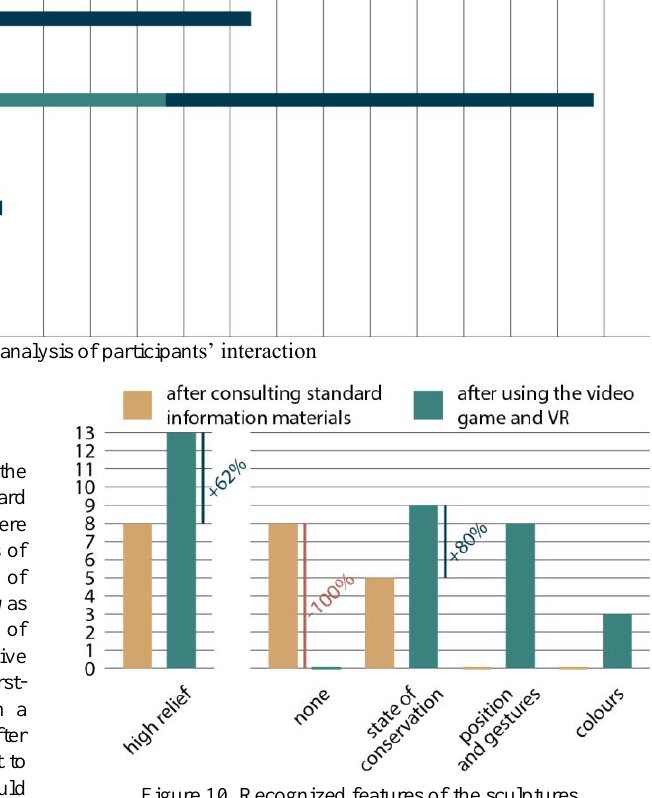
Figure 10. Recognized features of the sculptures